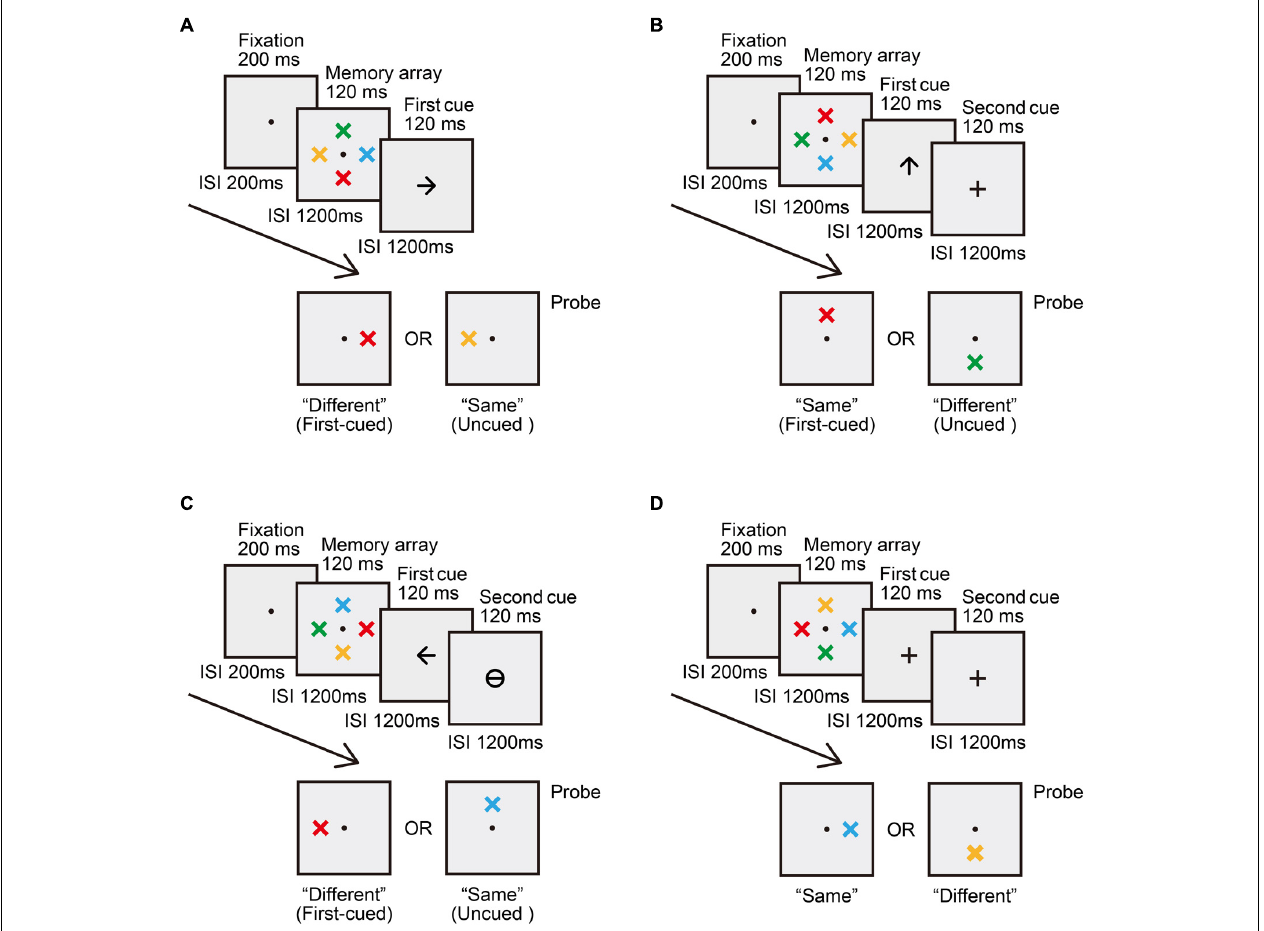
FIGURE 1 | Example trials for the four cue type conditions in Experiment 1. (A) The “single shift + early probe” (SE) condition. (B) The “single shift + late probe” (SL) condition. (C) The withdrawal condition. (D) The neutral condition.